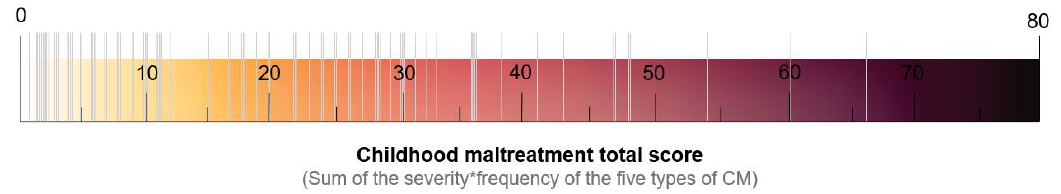
Figure 3. Distribution of subjects with a history of CM in the CM score (ranging from 1 to 80), considering the severity and frequency of each form of CM (emotional neglect, physical neglect, emotional abuse, physical abuse and sexual abuse).